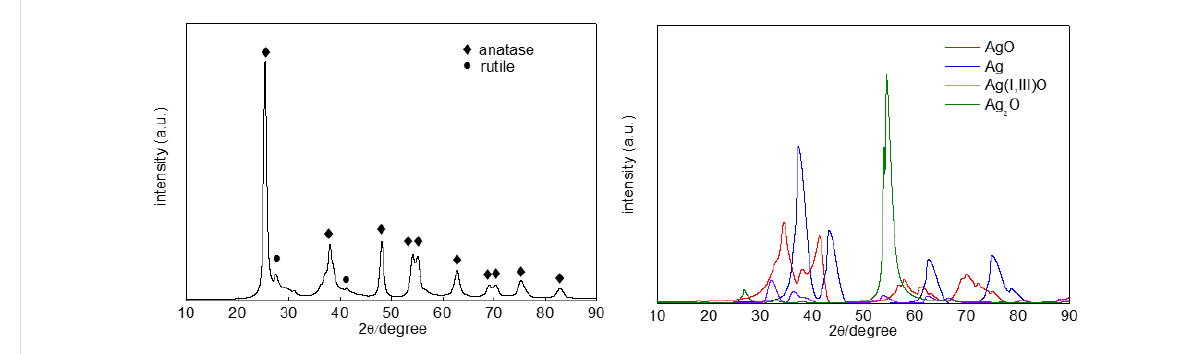
Figure 3: XRD patterns of Ag/TiO 2 (FP6): (left) original pattern, and (right) after subtraction of titania peaks.